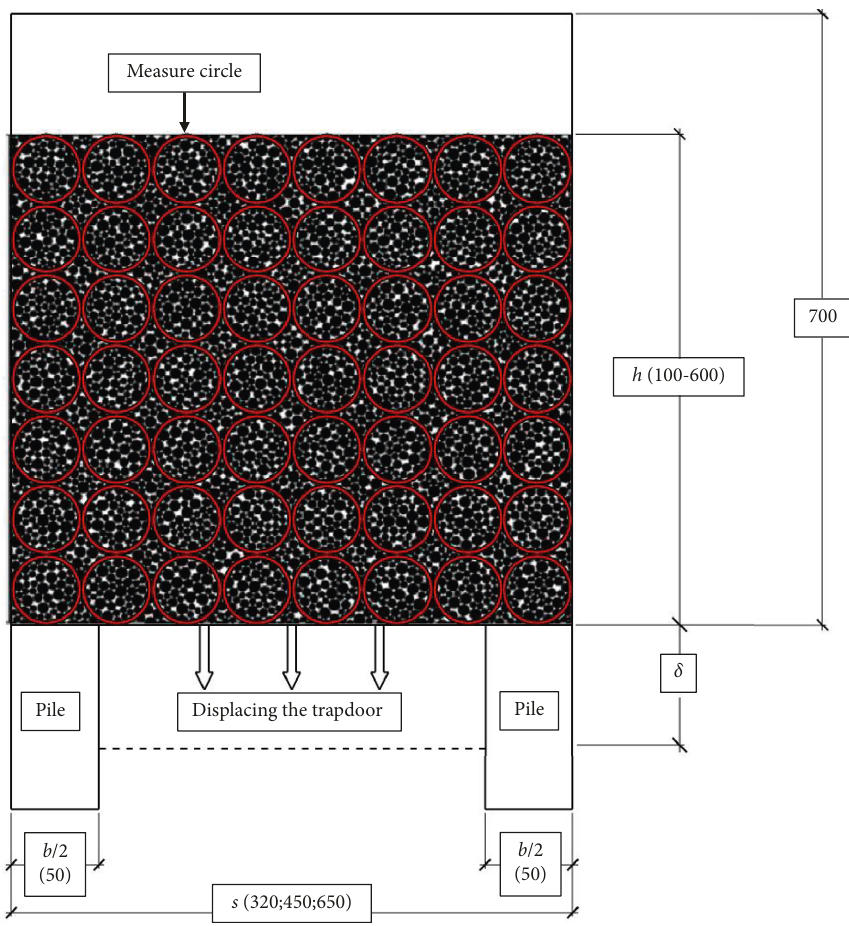
Figure 6: A schematic diagram of the numerical model (dimensions in